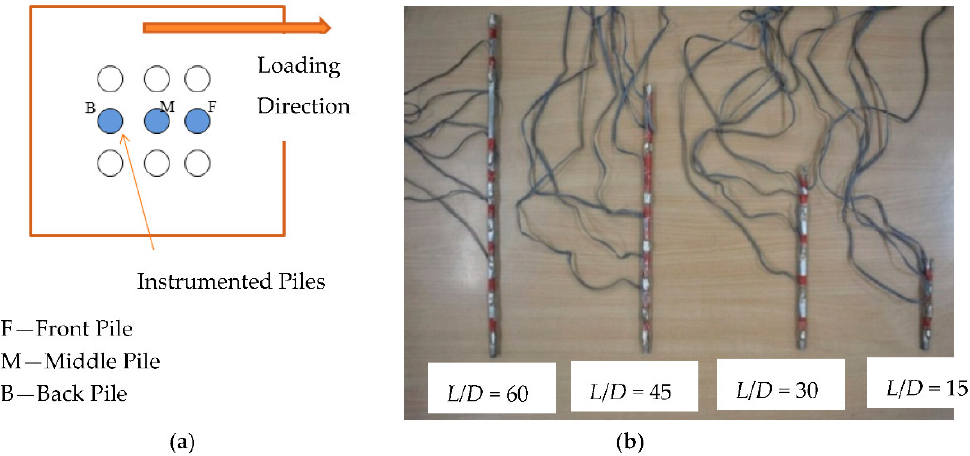
Figure 4. Instrumentation details: ( a ) details of the instrumented pile foundations, and ( b ) model piles with the strain gauges.